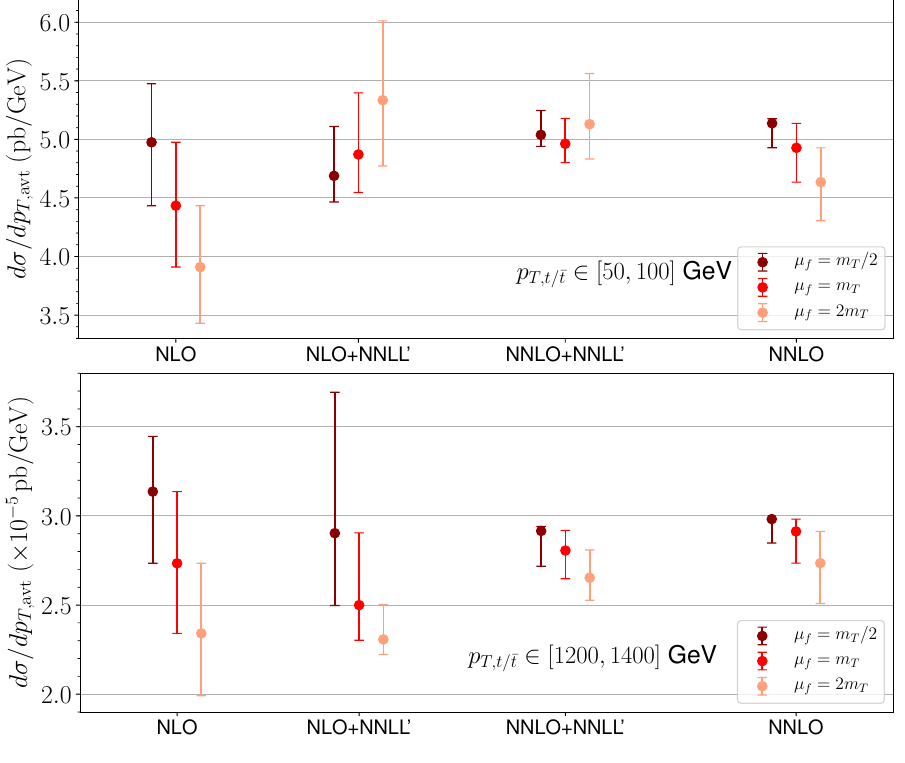
Figure 9 . Same as (cid:12)gure 8 but for the p T; avt distribution.